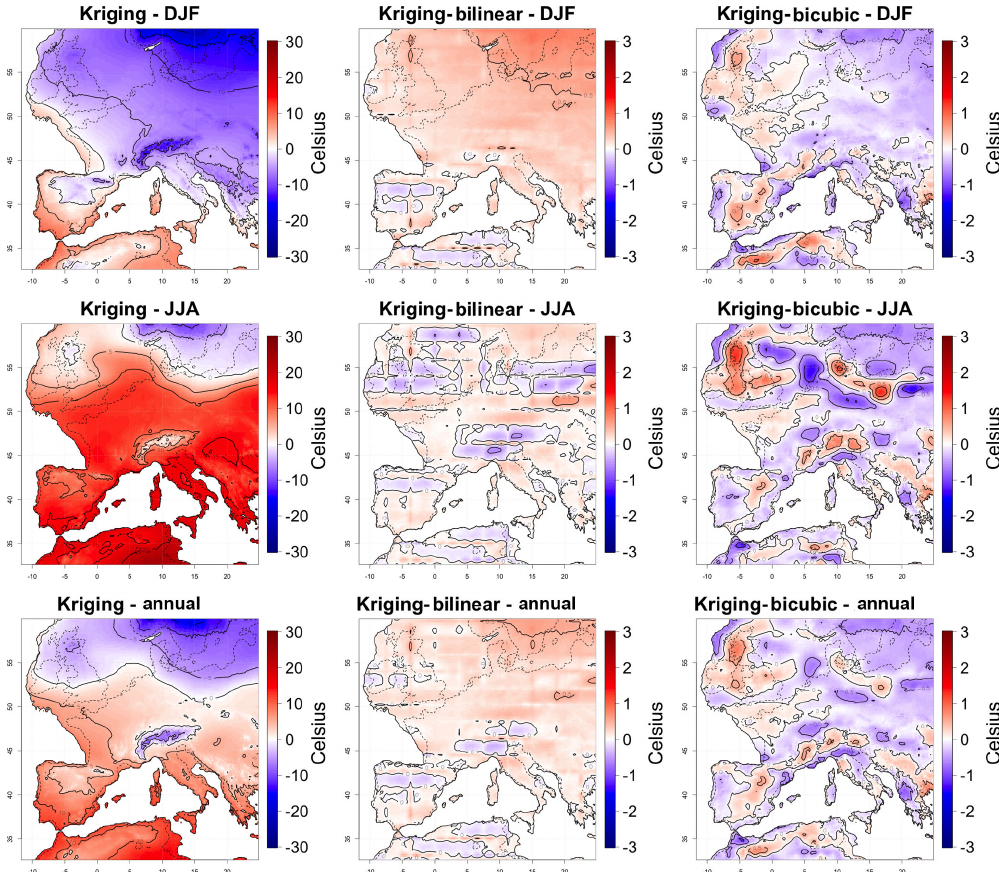
Figure 5. Mean distributions of monthly mean downscaled temperatures over western Europe during the LGM for winter (December, January, February), summer (June, July, August) and the whole year, computed over 50 years for the kriging interpolation technique, and difference between the kriging and the other two techniques. Downscaling was performed for each month independently, but results are combined into seasons to summarise the results.